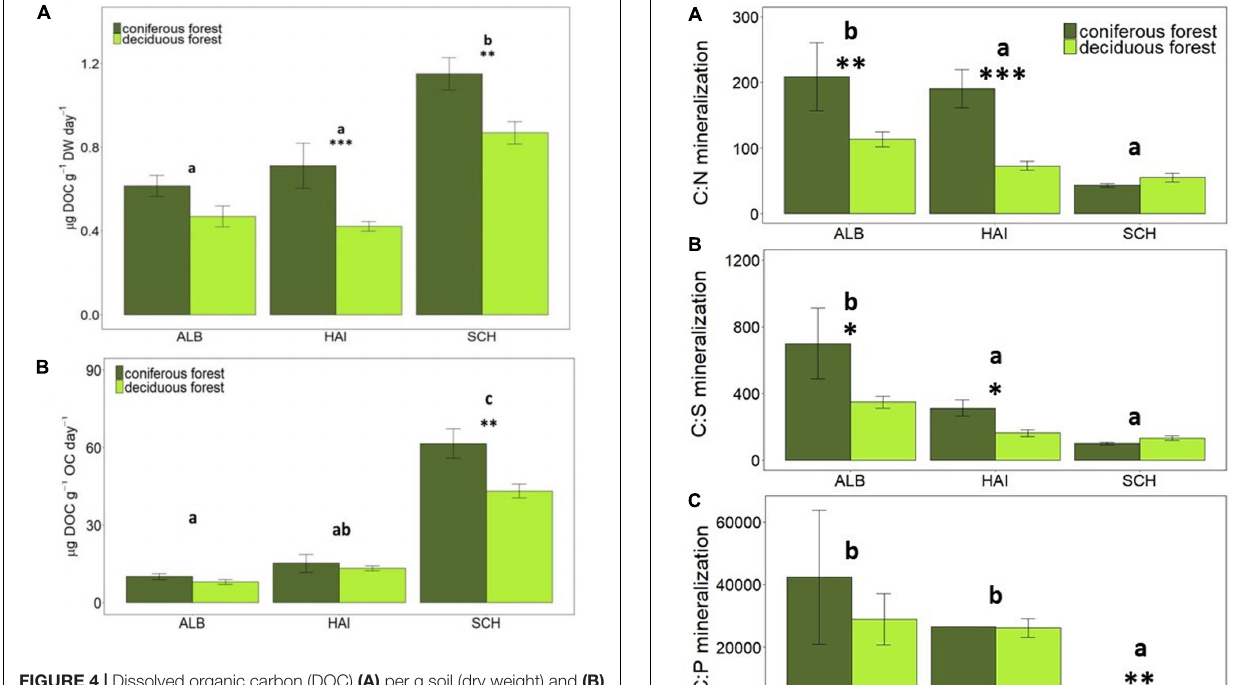
FIGURE 4 | Dissolved organic carbon (DOC) (A) per g soil (dry weight) and (B) per g SOC leached in different study regions and forest types. Error bars represent SE of means. X -axis represents study regions where ALB, Schwäbische-Alb; HAI, Hainich-Dün; SCH, Schorfheide-Chorin. Significant differences of variance between study regions are denoted by small letters, and between coniferous and deciduous forests by ∗∗ P < 0.01 and ∗∗∗ P < 0.001. Number of study sites included: ALB (deciduous forests, n = 38 and coniferous forest, n = 12), HAI (deciduous forests, n = 46 and coniferous forest, n = 4), and SCH (deciduous forests, n = 28 and coniferous forest, n = 22).